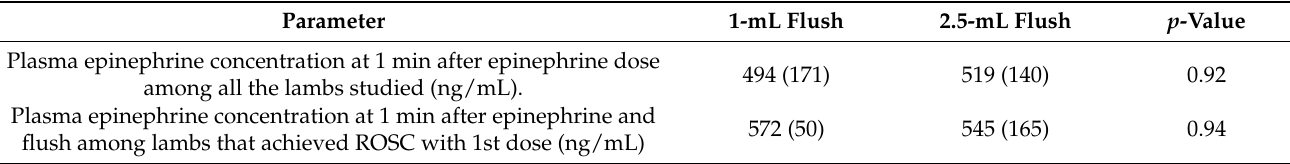
Table 2. Comparison of peak plasma epinephrine pharmacokinetics at 1 min following 1st dose of low UVC epinephrine at 0.03 mg/kg. Parameter 1-mL Flush 2.5-mL Flush p -Value Plasma epinephrine concentration at 1 min after epinephrine dose among all the lambs studied (ng/mL). Plasma epinephrine concentration at 1 min after epinephrine and flush among lambs that achieved ROSC with 1st dose